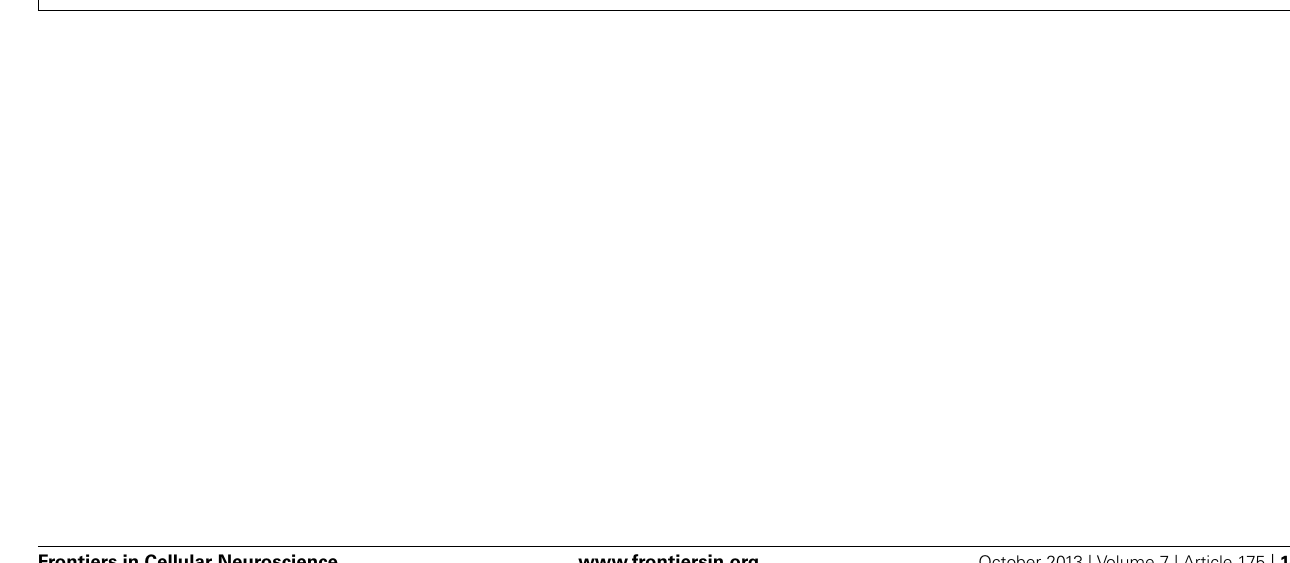
FIGURE A2 | Stem cell features of hNPs after multiple passages. After 16 passages, hNPs are still positive for Nestin (top panel). A low number of cells are positive for GFAP (bottom panel). The cells do not spontaneously differentiate during the multiple passages and maintain their stem cell